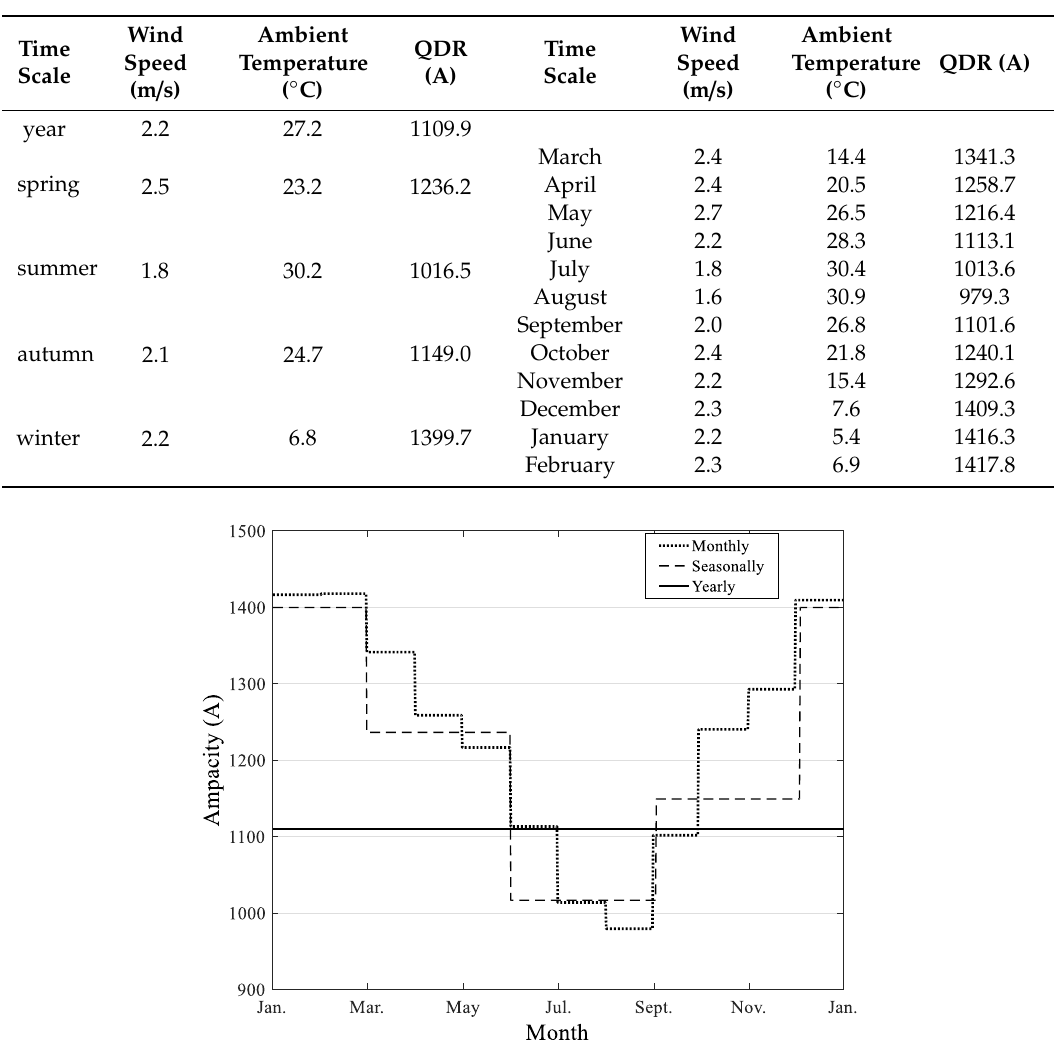
Table 1. Meteorological parameter thresholds and quasi-dynamic thermal ratings under confidence level of 95%.